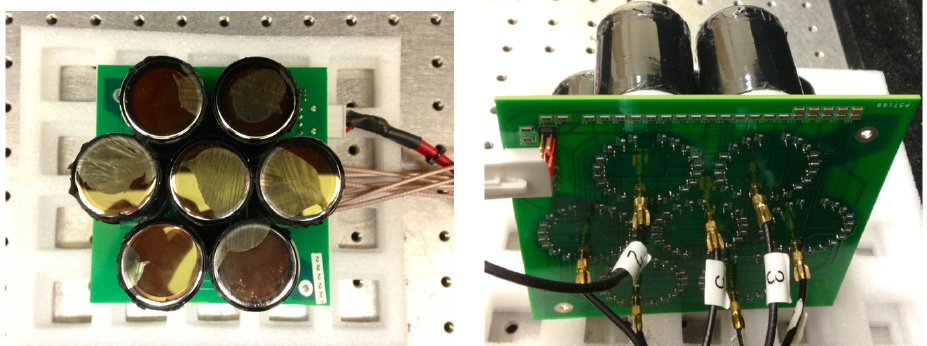
Figure 1. Pictures of the first SE module. Each sensor was 39 mm in diameter with an active window diameter of 27 mm. The length of the sensors was 50 mm.